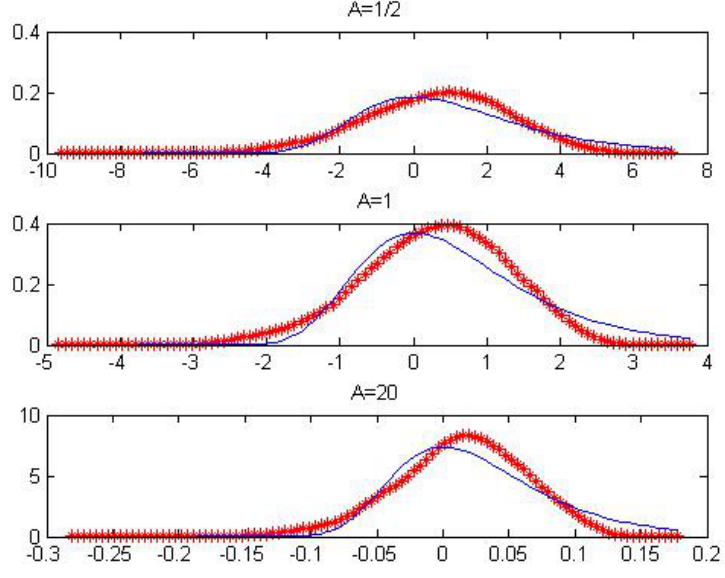
( x ) (red star) and f n ( x ) (blue line) for i.i.d. A , 1 and 20, respectively. 2